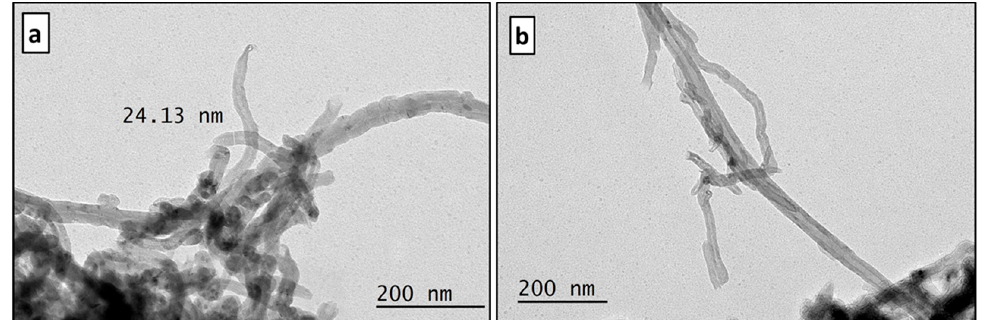
Figure 4. HRTEM images showing: ( a ) clusters of MWCNTs; ( b ) an individual MWCNT.